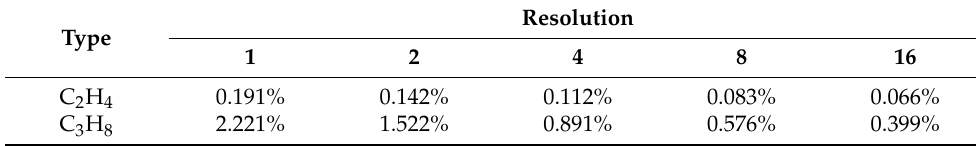
Table 4. The SD of the fitting residuals of the C 2 H 4 and C 3 H 8 spectra at different